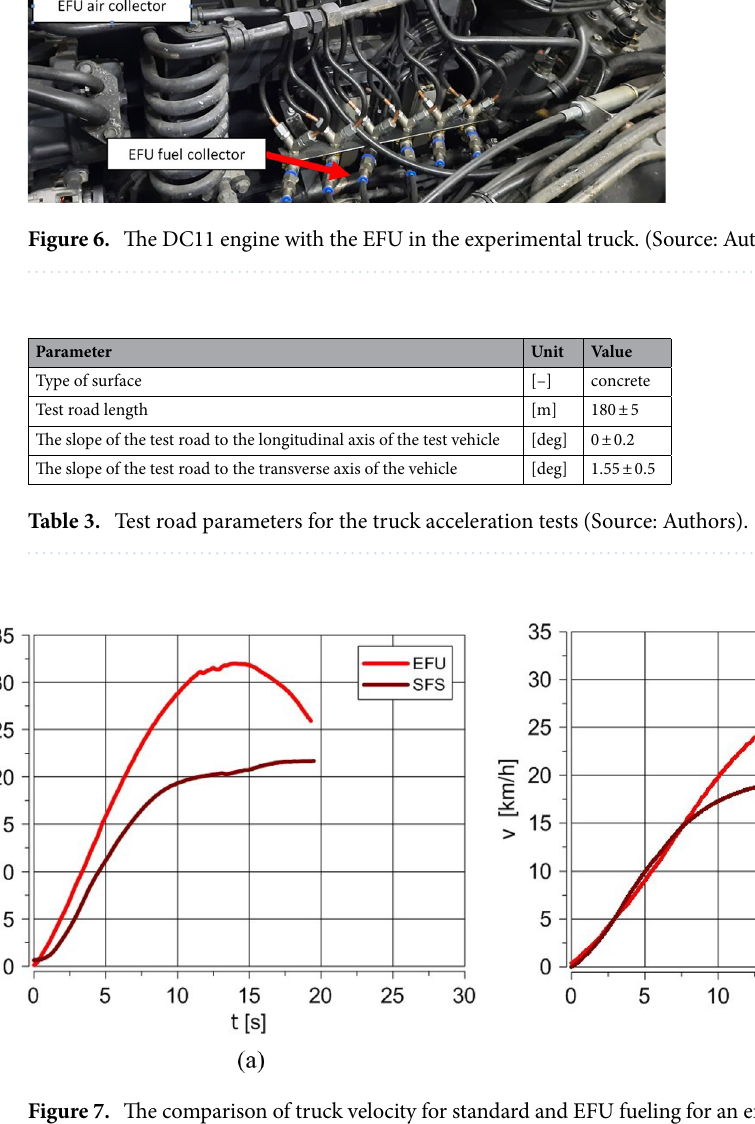
Figure 7. The comparison of truck velocity for standard and EFU fueling for an empty ( a ) and loaded truck ( b ) (EFU—Emergency Fueling Unit, SFS—Standard Fuel System). (Source: